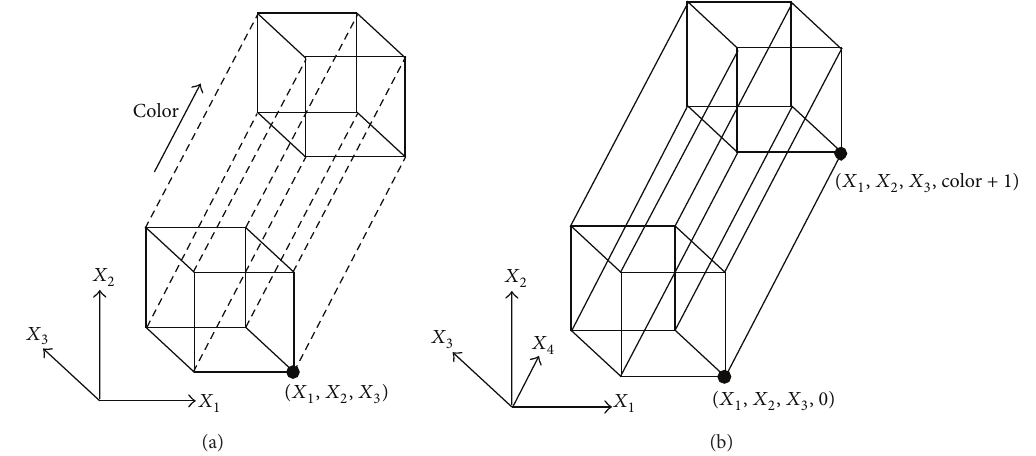
Figure 1: Extruding a voxel towards the fourth dimension. The result is a 4D hyperprism whose height is determined by the voxel’s intensity color. Table 1: Volume datasets used for conversion to 4D-OPPs and to be finally expressed through the 4D-EVM.